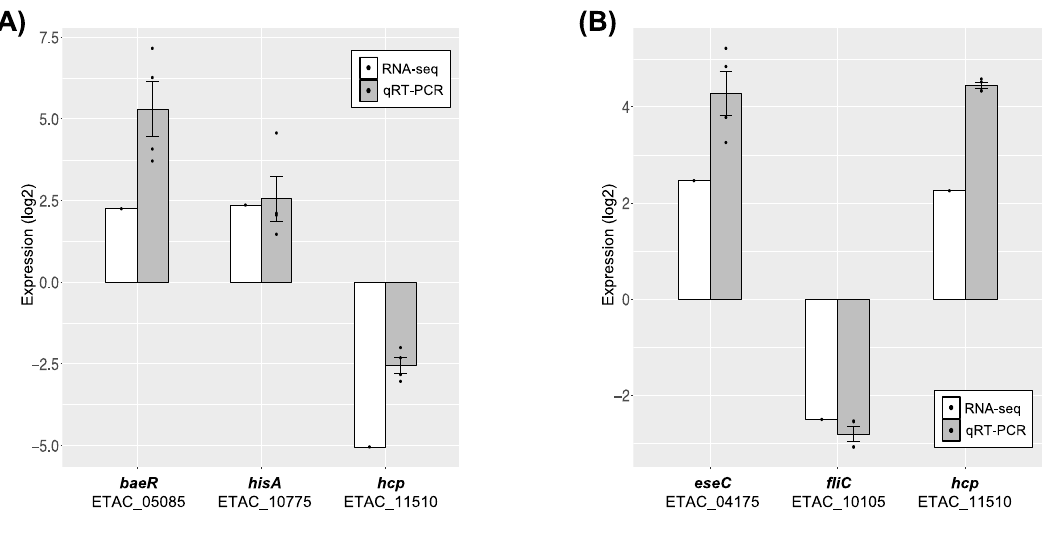
Figure 6. Validation of RNA-seq data by qRT-PCR. The expression levels of the selected genes in qRT- PCR were quantified through a comparison with the internal control gene of gapdh when cells were grown in the sub-ICs of ( A ) phenol or ( B ) formalin. A total of n = 4 (biological quadruplicate) samples were applied. Error bars represent the standard deviation of the mean.